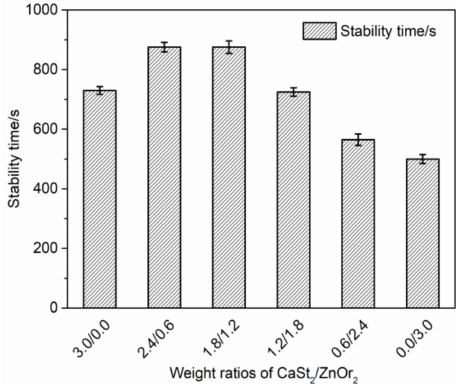
Figure 8. The effects of thermal stability time for PVC with different proportion of CaSt 2 /ZnOr 2 thermal stabilizers at 180 ◦ C.